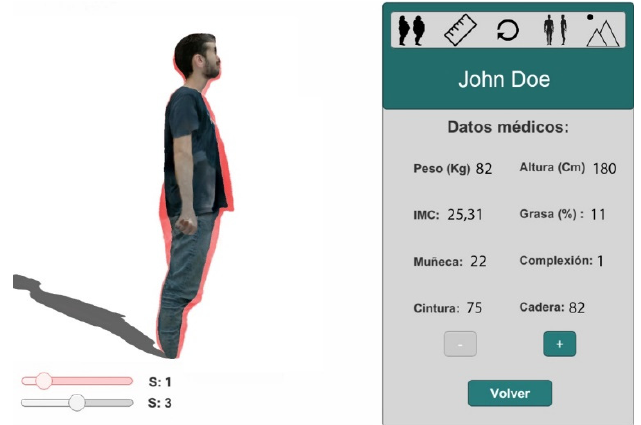
Figure 7. 4D visualization of a sequence of 3D models, comparing sessions.